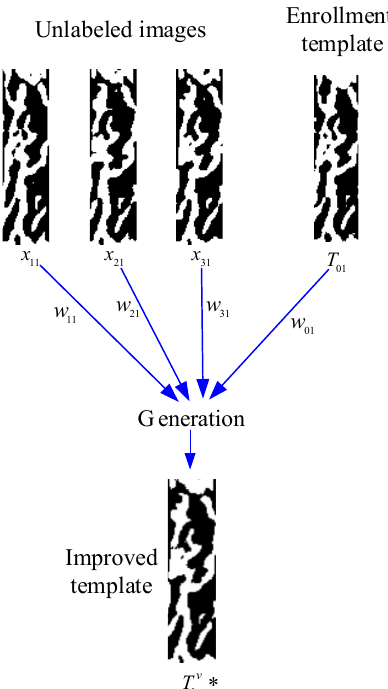
Figure 5. A sample for template improvement. Three unlabeled images are employed to improve the enrollment template and an improved template T v